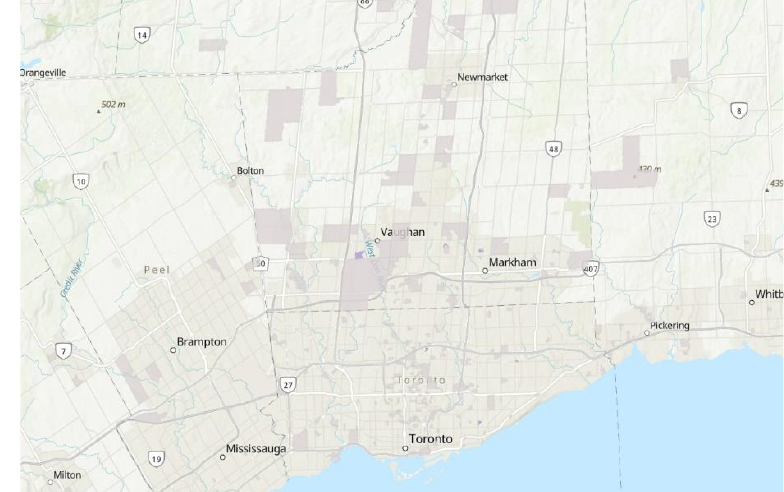
Figure 2. Average Delay Time of Examinations between the beginning of vaccinations period (period 3) and the height of the COVID-19 pandemic period (period 2) per Dissemination Area. A map of Greater Toronto Area, Ontario, Canada with patients aggregated by dissemination area and average delay time (days) calculated for each dissemination was produced by ArcGIS online. Dissemination areas of patients are marked by a gradient based on delay time. The darkest purple shows a delay in examination >180 days while the lightest purple shows a delay in examination <90 days. Dissemination areas with no color have no patient data.